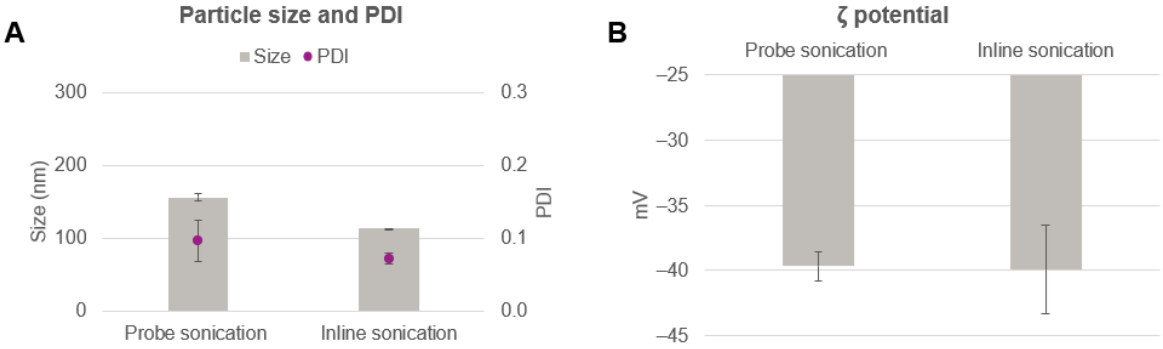
Figure 3. ( A ) Particle size and PDI and ( B ) zeta potential of placebo PLGA nanoparticles generated via probe direct and inline indirect sonication.